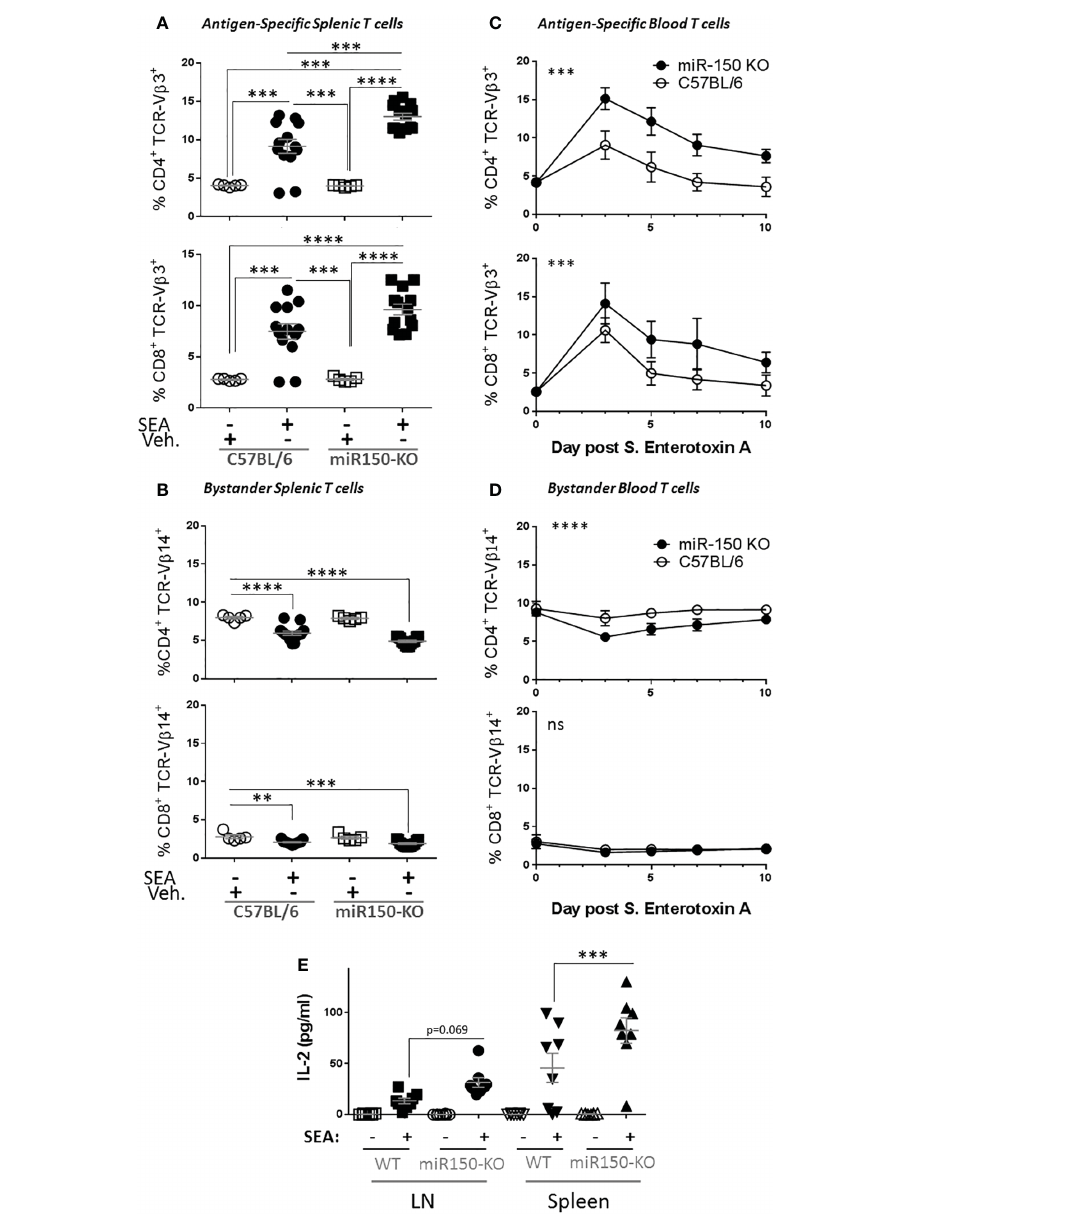
FIGURE 2 miR-150 controls T cell expansion after immunization. (A) Splenocytes from wild type (WT; C57BL/6) and miR-150-KO mice were analyzed by fl ow cytometry 48 h post-immunization with S. aureus enterotoxin A (SEA) or vehicle (Veh.) as described in Figure 1A. Percentage of antigen-speci fi c (TCR-V b 3) CD4 + (top row) and CD8 + (bottom row) T cells are shown. (B) Percentage of bystander (TCR-V b 14) CD4 + (top row) and CD8 + (bottom row) T cells are shown. Data shown are individual biological replicates from 3 independent experiments +/- s.e.m. Statistical signi fi cance was evaluated by one-way ANOVA student ’ s t-test. (C) Mice immunized with SEA were bled every 2 or 3 days, and blood cells were analyzed as described in Figure 1A. Percentage of antigen- speci fi c (TCR-V b 3) CD4 + (top row) and CD8 + (bottom row) T cells are shown. (D) Percentage of bystander (TCR-V b 14) CD4 + (top row) and CD8 + (bottom row) T cells are shown. Each line represents the average from 8 mice from 2 independent experiments. Statistical signi fi cance was evaluated by two-way ANOVA. (E) 10-days post-SEA immunization, lymph node cells (four left panels) and splenocytes (four right panels) from miR-150 and WT mice were re- stimulated with SEA or vehicle, culture supernatant was obtained after 18 h and analyzed by multiplex ELISA for 17 analytes (Supplementary Figure 1). Secretion of IL-2 is shown. Each dot represents an independent biological replicate from 2 independent experiments. Data shown are individual biological replicates +/- s.e.m. Statistical signi fi cance was evaluated by 1 way ANOVA. (ns: non-signi fi cant, **p < 0.01, ***p < 0.001; ****p <